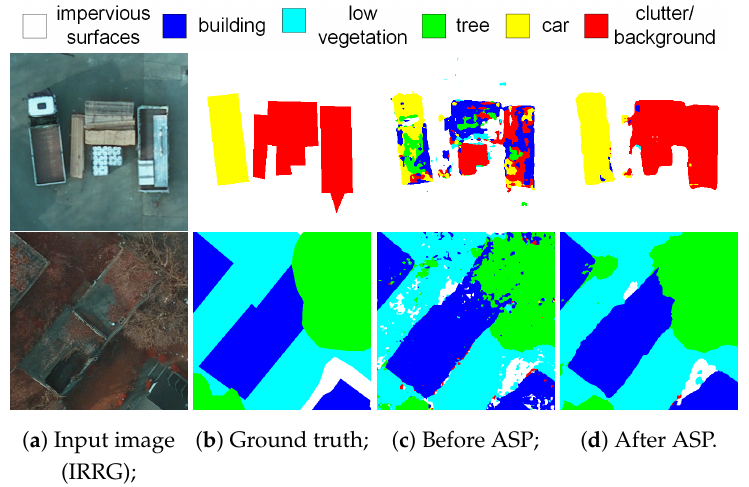
Figure 6. Comparison of classified high-resolution features before and after the use of the adaptive spatial pooling (ASP) module (Potsdam